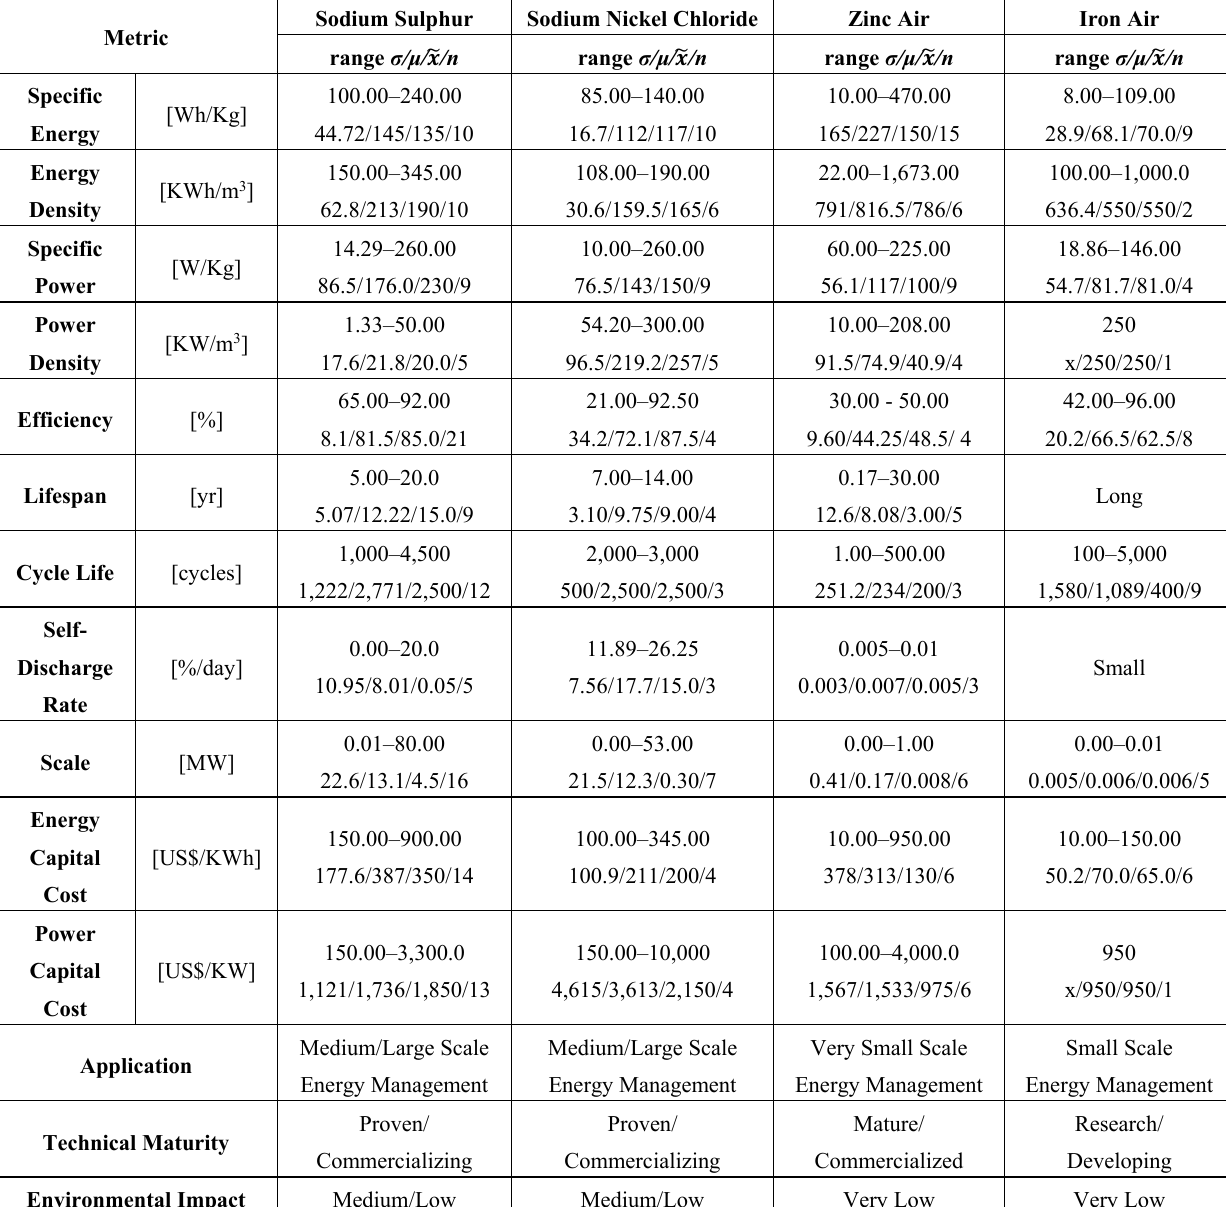
Table 6. Comparing molten salt and metal-air chemical batteries based on fourteen different metrics. Data obtained or calculated from multiple sources